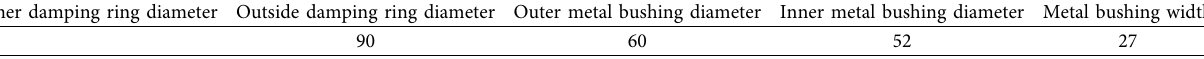
Table 3: Geometric parameters of the shaft damping ring